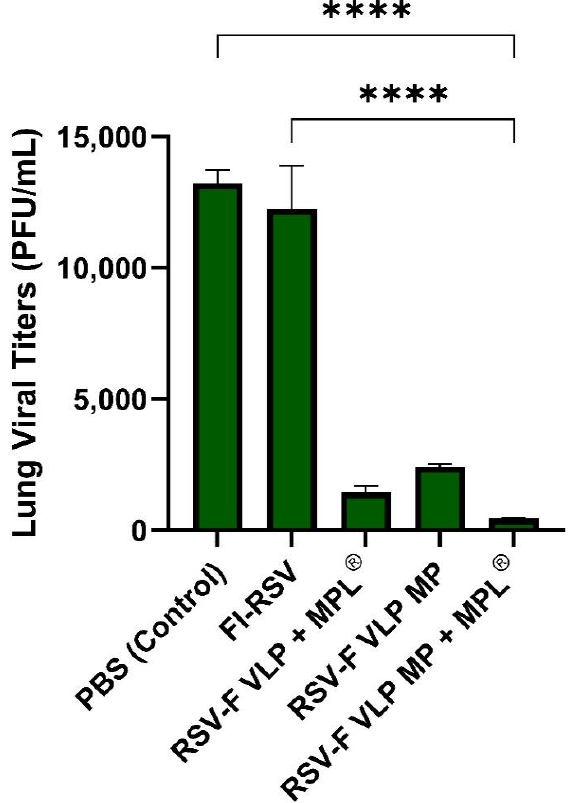
Figure 5. Lung viral titers quantified using RT-PCR. Lung samples from mice ( n = 5) from all groups were harvested at week 14 and homogenized. Lung viral titers were quantified via extraction of total RNA and quantified using RT-PCR. Statistical significance was determined using one-way ANOVA in GraphPad Prism. **** p < 0.0001.